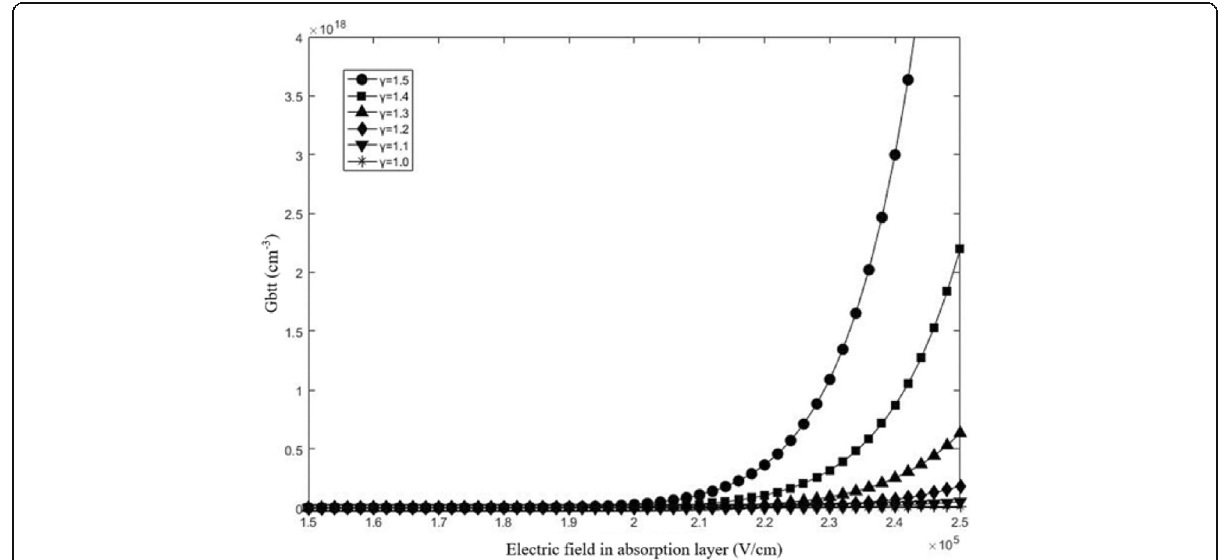
Fig. 5 The G btt for different fields in absorption layer with different γ . The values of γ is 1.0 (black star), 1.1 (black down-pointing triangle), 1.2 (black diamond), 1.3 (black triangle), 1.4 (black square), 1.5(black circle). Presents the calculated results of G btt by Formula 13. When the field of absorption exceeds 19 kV/cm, G bbt gradually increases. It also can be found that G bbt adapts the same order of magnitude for the charge layer doping level while γ is restricted to